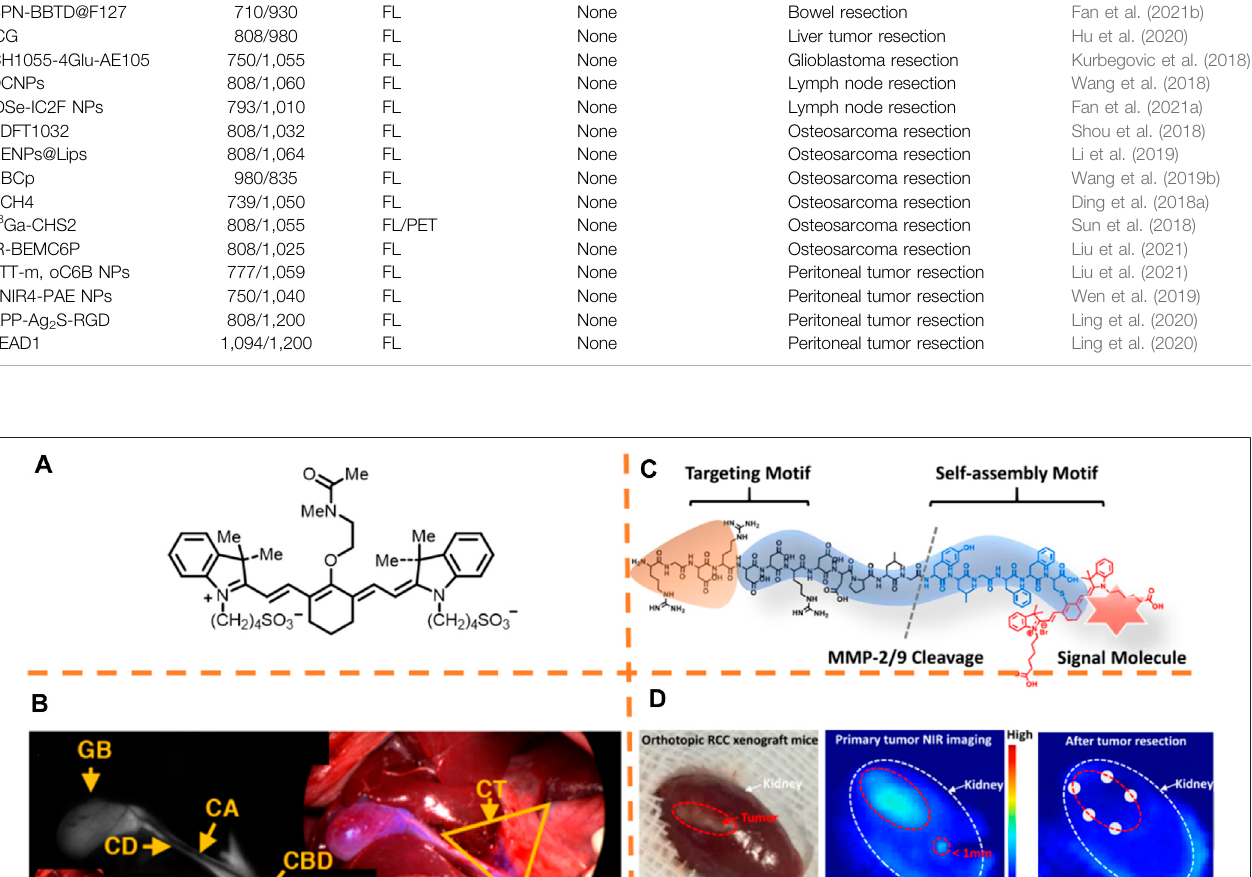
Frontiers in Bioengineering and Biotechnology |